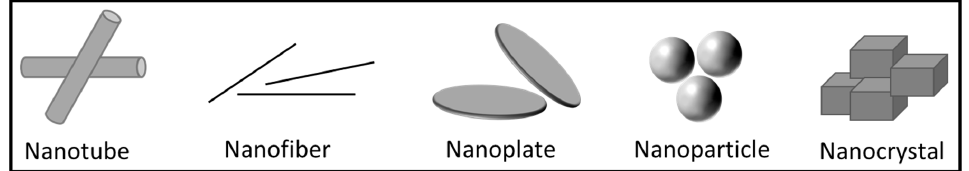
Figure 3. Examples of various nanoscale filler morphologies used in polymer nanocomposites. Adapted from [37].